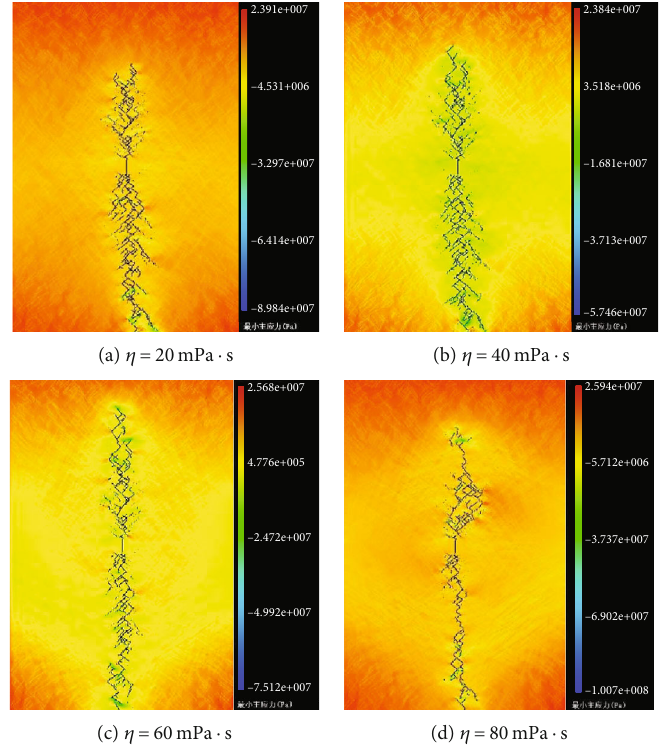
Figure 21: Hydraulic fracture propagation patterns under di ff erent fracturing fl uid